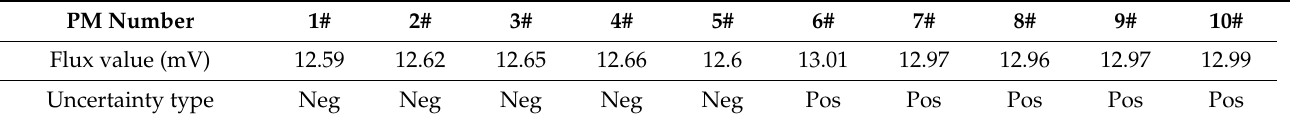
Table 7. The magnetic flux of the ten selected PMs.